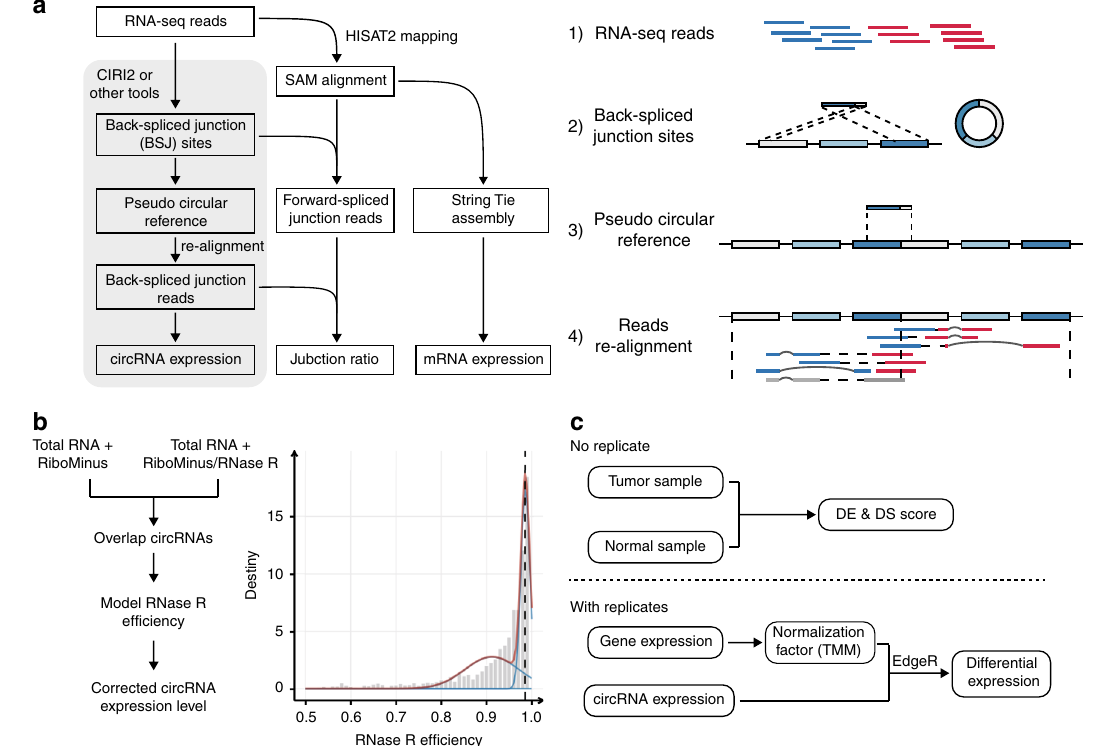
Fig. 2 Overview of the CIRIquant pipeline. a Work fl ow of circRNA quanti fi cation. CircRNAs are fi rst identi fi ed by CIRI2 or any other computational methods. Then, CIRIquant detects back-spliced junction reads using re-alignment of RNA-seq reads against the pseudo-circular reference. Expression level and junction ratio of circRNAs are calculated using BSJ reads and FSJ reads, and stringTie is used to estimate gene abundance. b The correction of RNase R treatment ef fi ciency. Overlapped circRNAs detected in both RiboMinus and RiboMinus/RNase R data are used for enrichment ef fi ciency calculation and a gaussian mixture model (GMM) is used for model fi tting. The fi tted model is used as prior distribution for the correction of circRNA expression values. c Differential expression analysis of circRNAs. Top: For paired samples without replicates, DE-score and DS-score is directly calculated using generalized fold change. Bottom: For paired samples with biological replicates, gene expression values are used to calculate normalization factor, then the modi fi ed edgeR pipeline is used for statistical signi fi cance